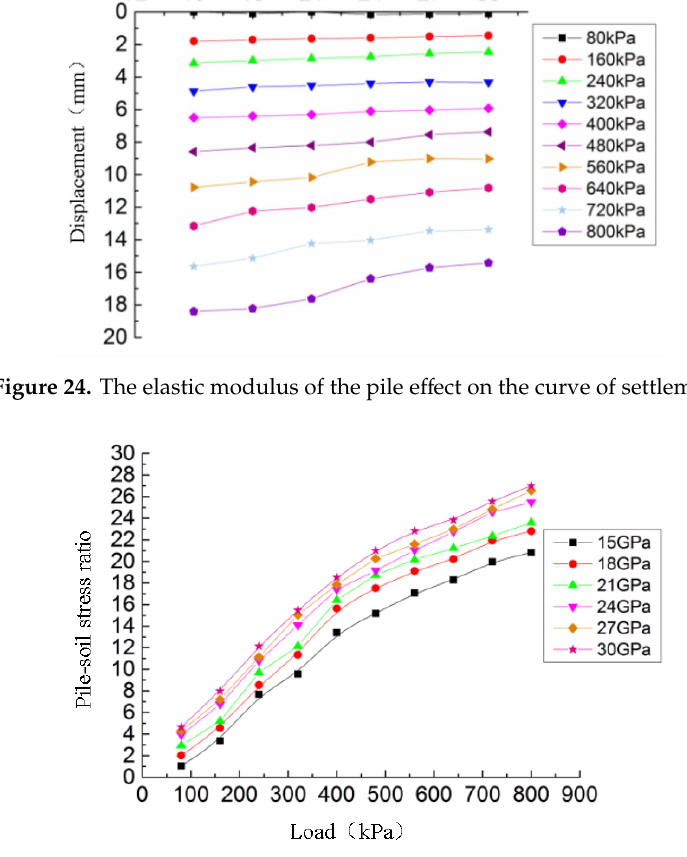
Figure 25. The elastic modulus of the pile effect the pile-soil ratio.